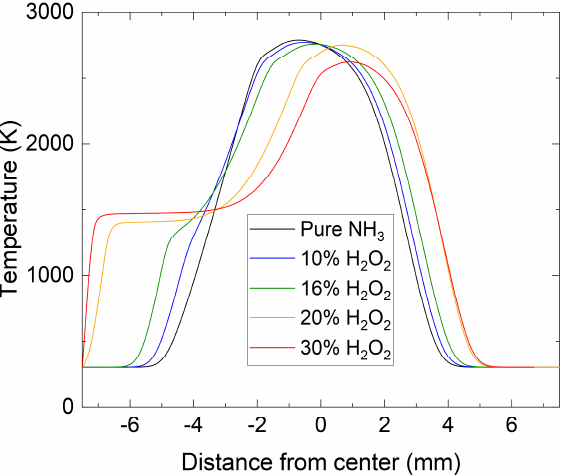
Figure 2. Temperature along the centerline as a function of spatial location and H 2 O 2 content in the fuel stream.